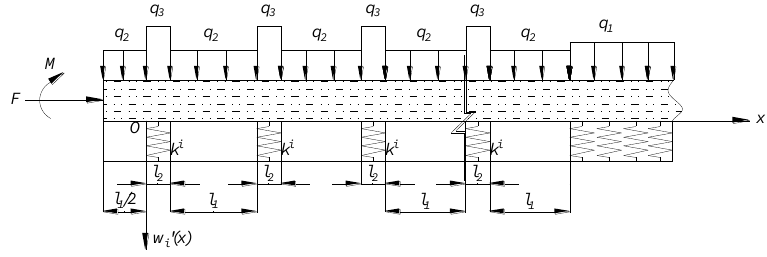
Figure 7. Mechanical model of the strata when the number of blocks was odd.